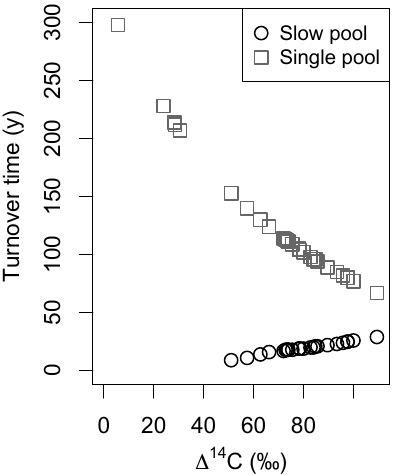
Figure 3. Relationships between (cid:49) 14 C of the mineral-associated fraction and modeled turnover time. Circles represent the slow mineral-associated pool, which comprised most (66 ± 2%) of the total mineral-associated C. Squares represent a single-pool model of mineral-associated C, which has commonly been employed in other studies but could not be fit to both our 1988 and 2012